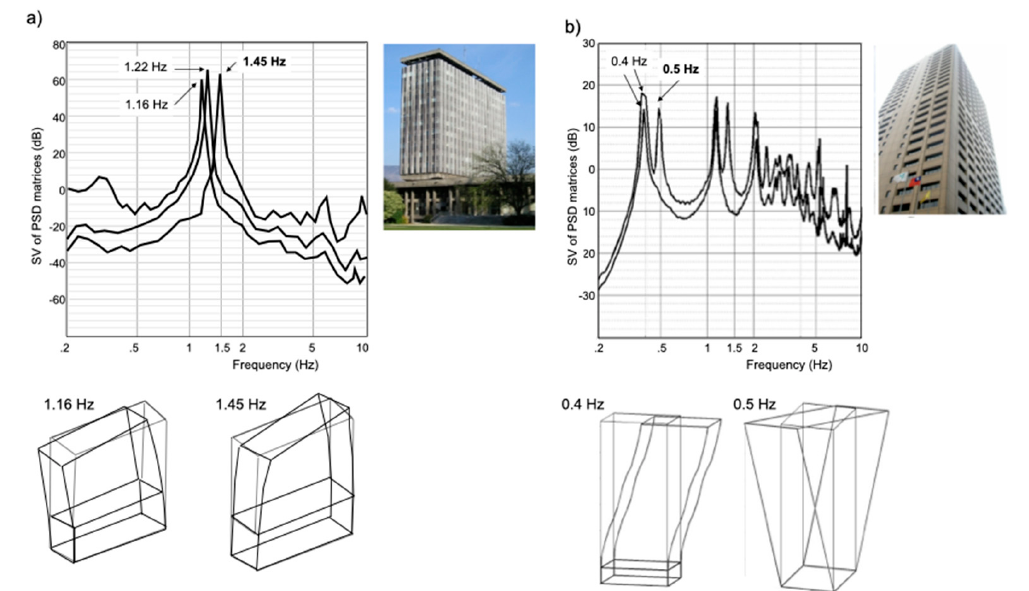
Figure 2. Examples of operational modal building responses using ambient vibrations by Frequency Domain Decomposition. ( a ) City-Hall building in Grenoble (France). ( b ) Taipo Tower in Taipei (Taiwan). Singular value decomposition and examples of experimental mode shapes including torsion are given with resonance frequencies in translation and in torsion (in bold).